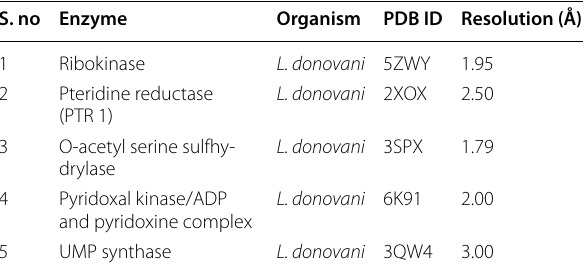
Table 3 Description of the various enzymes used for the target fishing